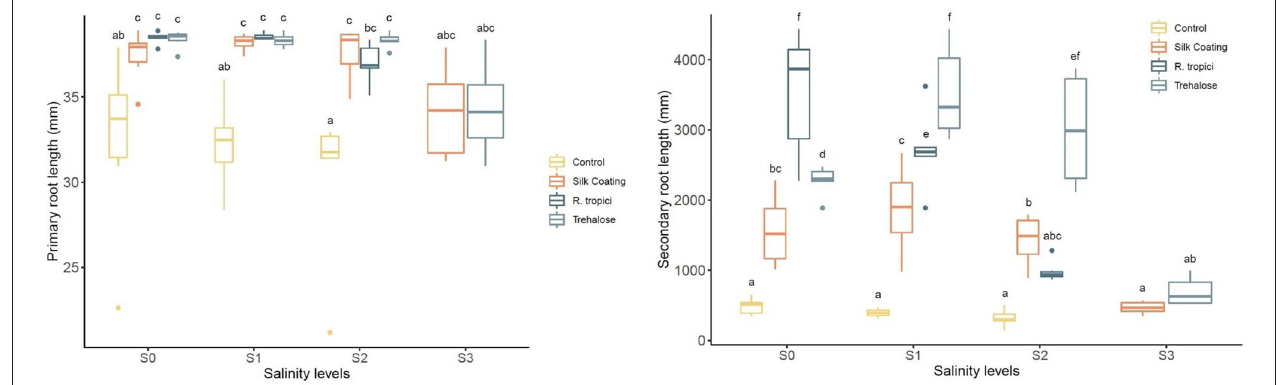
FIGURE 5 | Phaseolus vulgaris primary roots length (left) and lateral root length (right) under different seed treatments and salinity